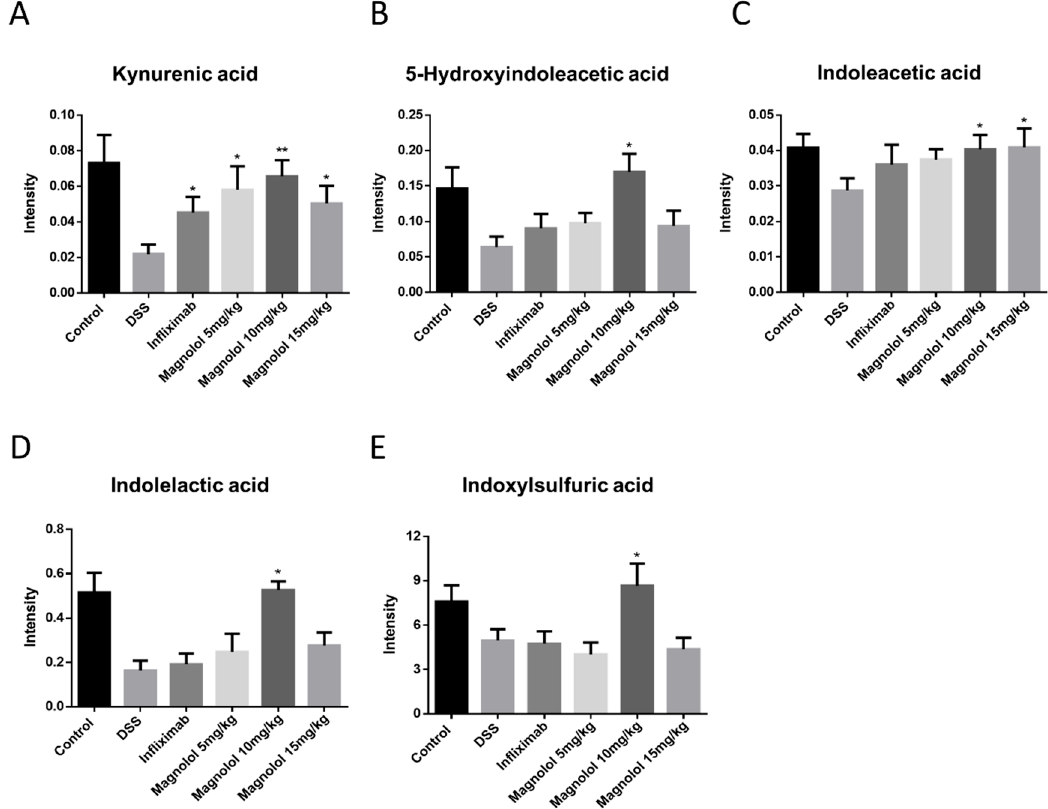
Figure 5. Reduction of serum metabolites kynurenic acid ( A ), 5-hydroxyindoleacetic acid ( B ), indoleacetic acid ( C ), indolelactic acid ( D ) and indoxylsulfuric acid ( E ) involved in tryptophan metabolism was significantly raised by magnolol treatment. The value in the plot was expressed as means ± SEM, and statistically significant was marked by asterisk (* p < 0.05; ** p < 0.01).